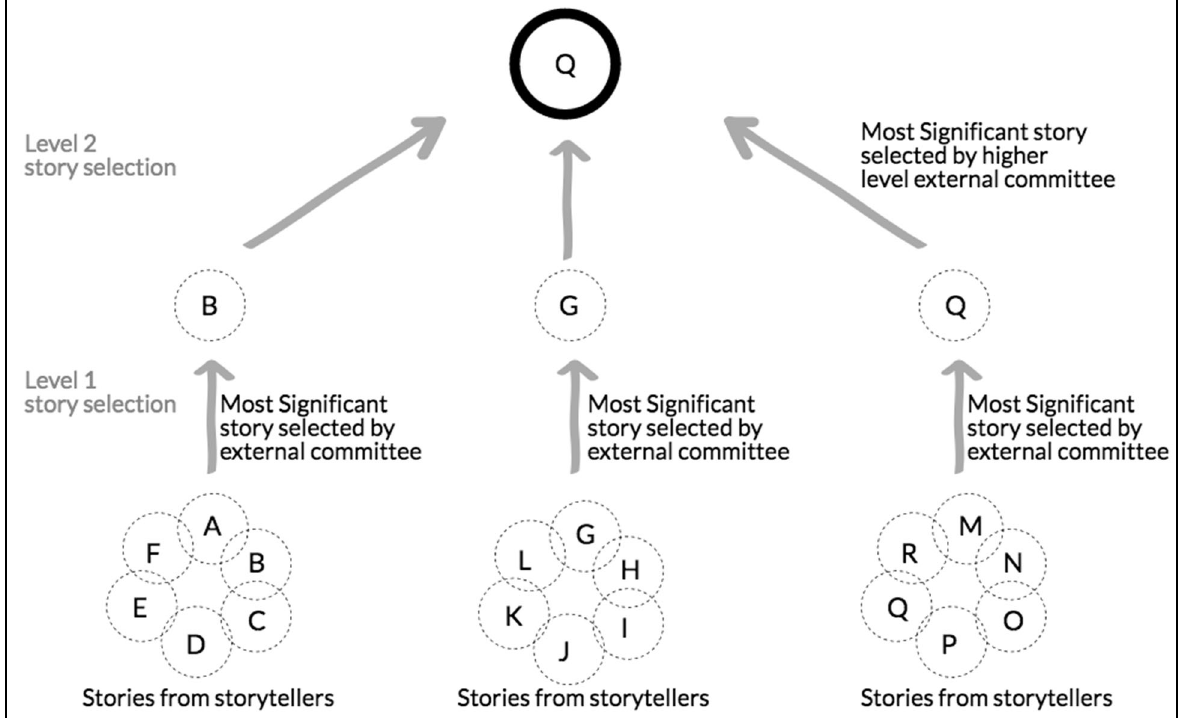
Figure 1. The Typical Process of Collecting and Identifying the “Most Significant” Stories